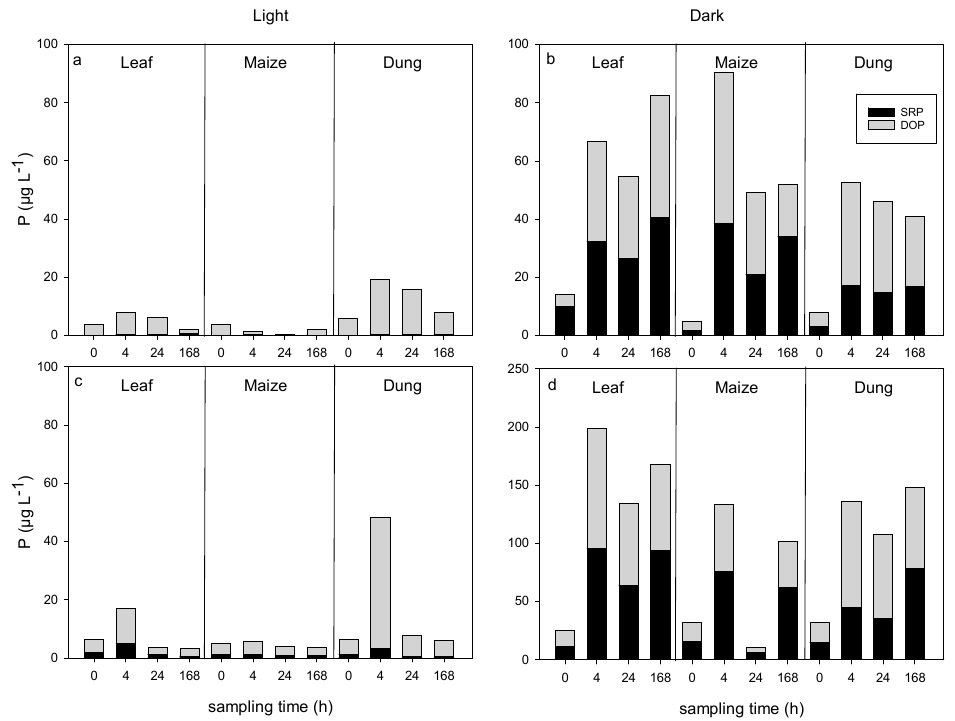
Figure 1. Changes in dissolved inorganic (SRP) and organic (DOP) phosphorus concentrations in the water column in leaf, maize, and dung treatments under light and dark conditions before (0) and 4, 24, and 168 h after the leachate additions during run 1 ( a , b ) and 2 ( c , d ) ( n = 3).